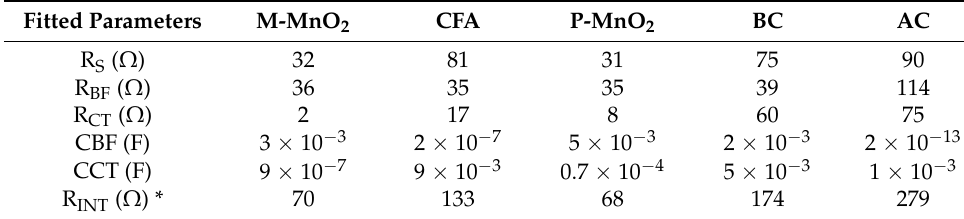
Table 1. Fitting parameters from EIS